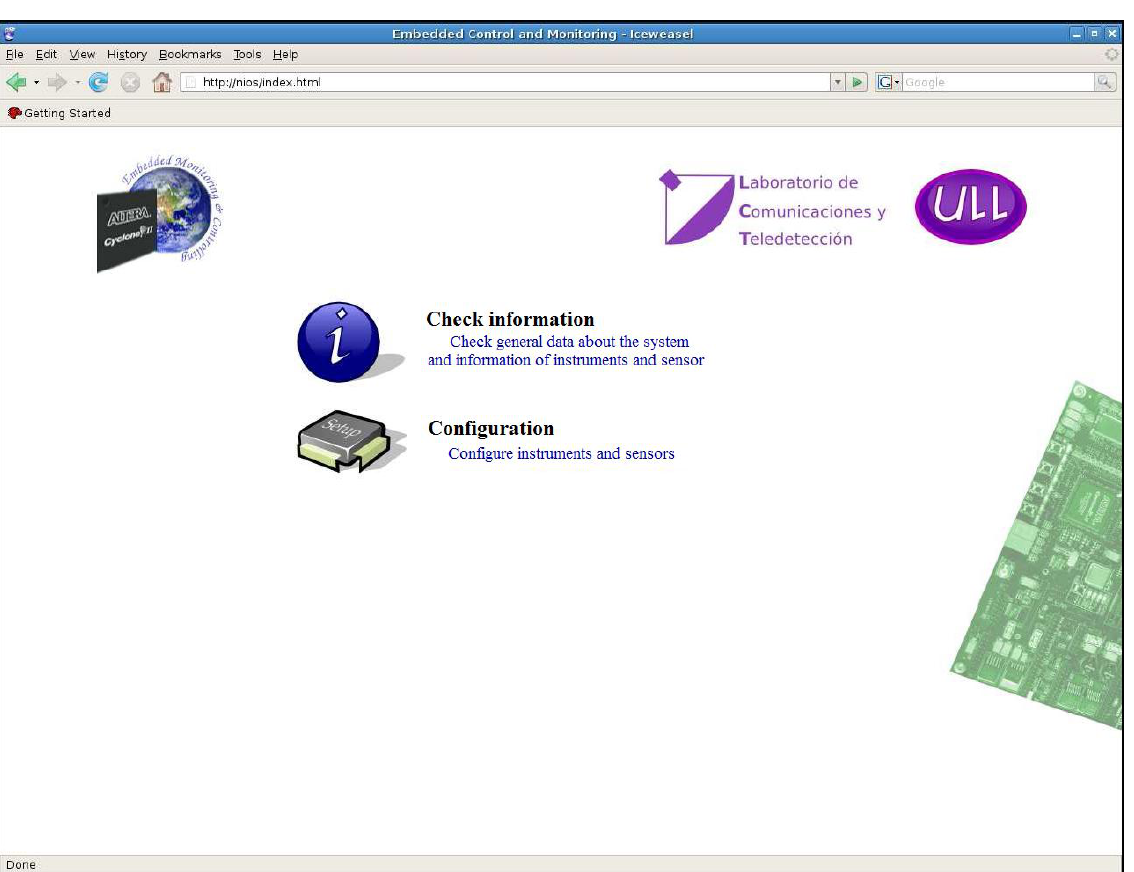
Figure 11. Web interface